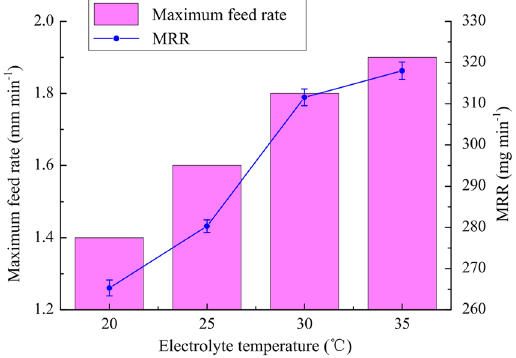
Figure 11. Variations of maximum feed rate and MRR with electrolyte temperature.